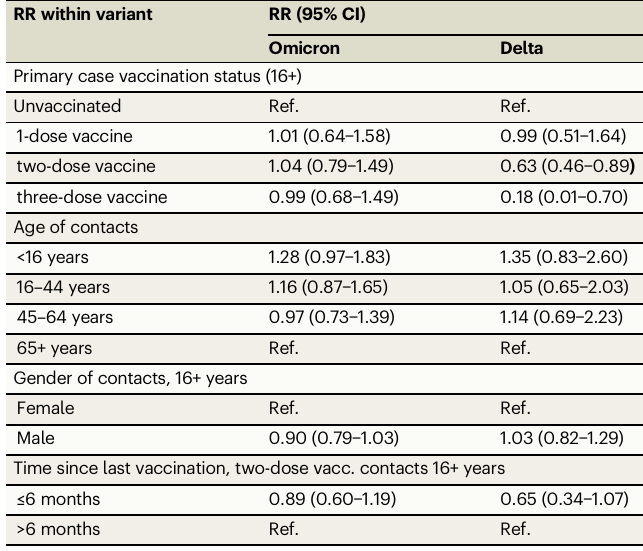
Table 3 | Relative risk of Omicron and Delta infection strati fi ed by different